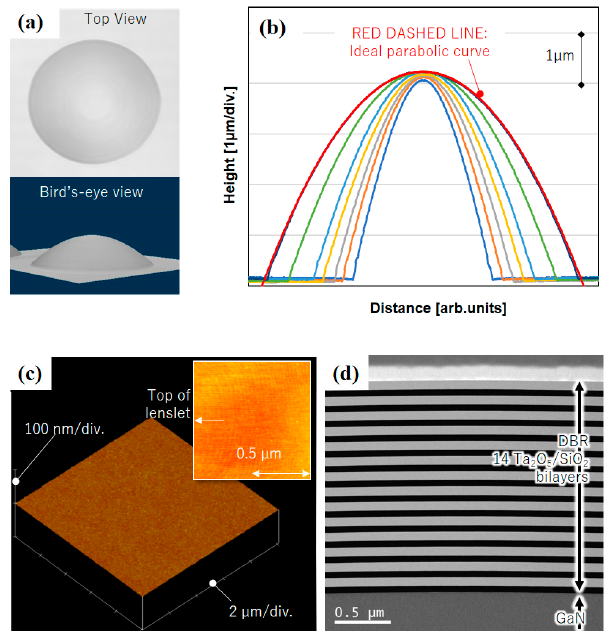
Figure 7. ( a ) Laser scanning confocal microscope images and ( b ) cross-sectional profiles of lenslets fabricated on the (000-1) plane of GaN wafers. In ( b ), multiple profiles acquired from specimens having different diameters are overlaid, while the red dashed line is an ideal parabolic curve fitted to one of the plots. ( c ) AFM image of the top of a lenslet fabricated on the (000-1) plane of a GaN substrate. The inset is a high-resolution image of a 1 µ m × 1 um area that shows atomic steps on the surface. ( d ) Cross-sectional TEM image of the curved mirror of the device used for an optical pumping